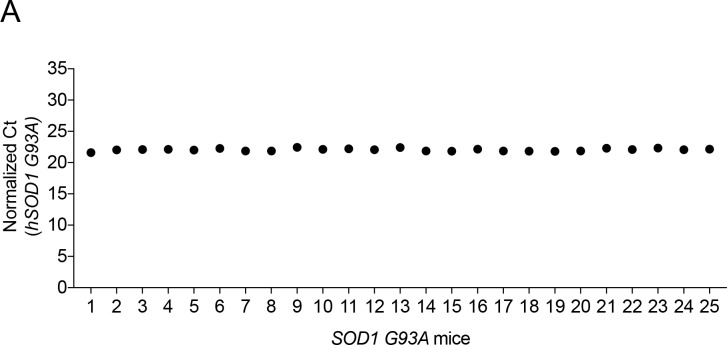
hSOD1-G93A copy number remained unchanged over generations and throughout the experiments.(A) The copy number of the human SOD1-G93A gene was quantified by real-time PCR and normalized to GAPDH. All mice included in this study had 21–26 copies of hSOD1-G93A. The normalized hSOD1-G93A Ct values are shown for 25 samples (filled circles).